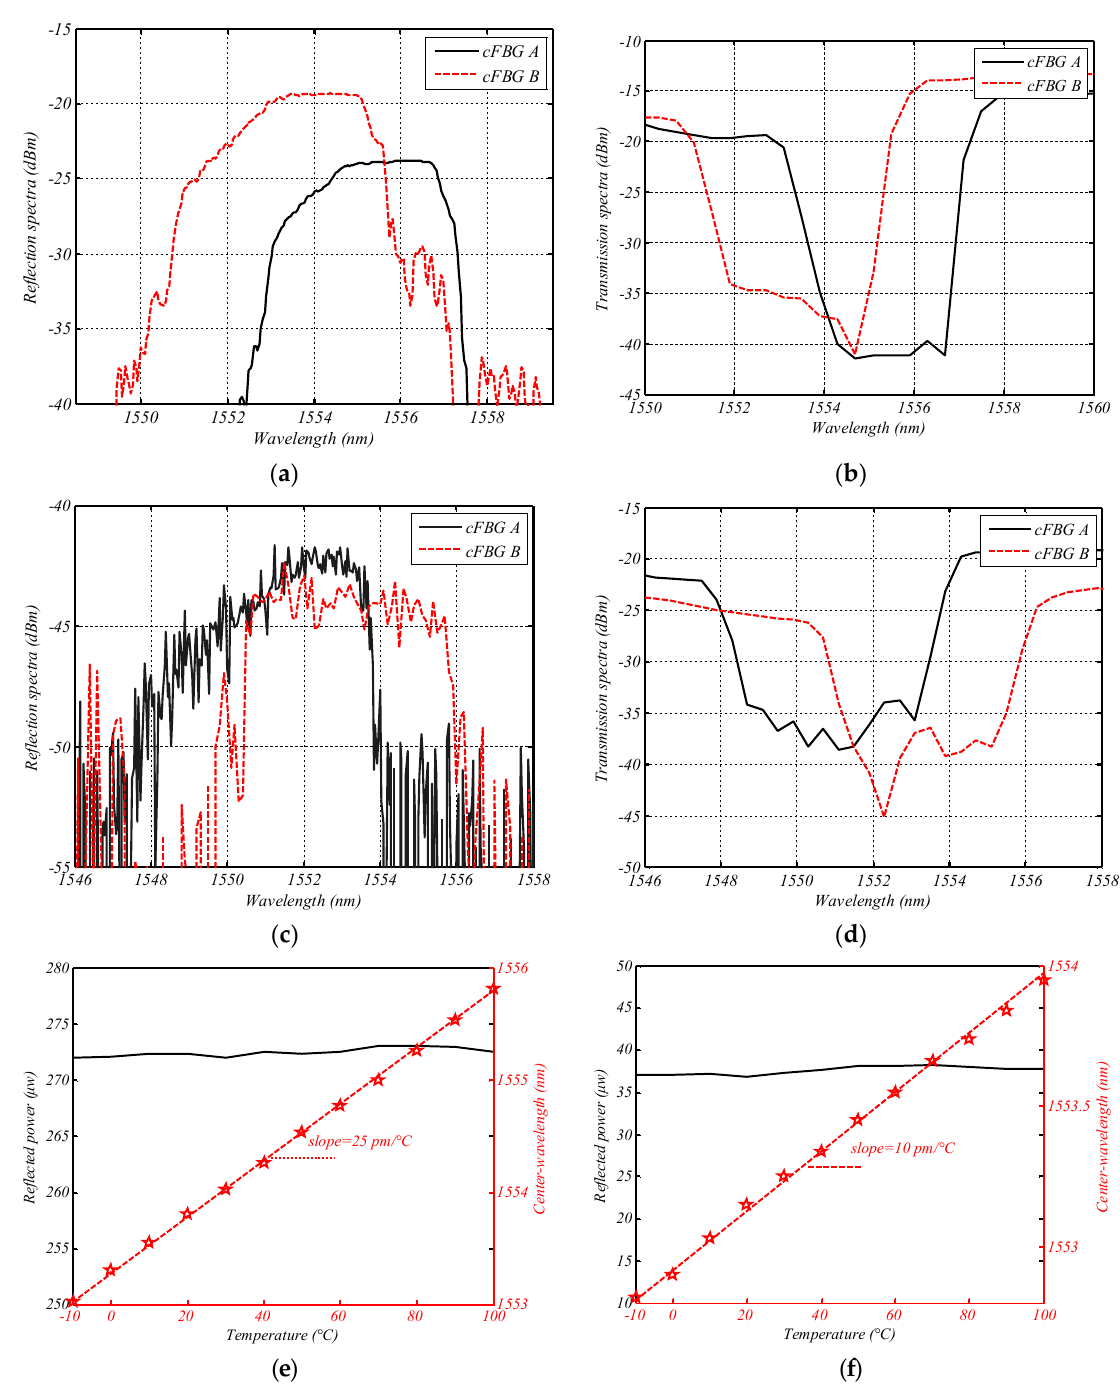
Figure 6. Reflection spectra, transmission spectra, and temperature characteristics of chirp FBGs (cFBGs) at a constant temperature (15 °C) for ( a ) reflection spectra of Group I; ( b ) transmission spectra of Group I; ( c ) reflection spectra of Group II; ( d ) transmission spectra of Group II; ( e ) reflected power vs. temperature, and center-wavelength vs. temperature for the cFBG B used in Group I; and ( f ) reflected power vs. temperature, and center-wavelength vs. temperature for the cFBG B used in Group II.